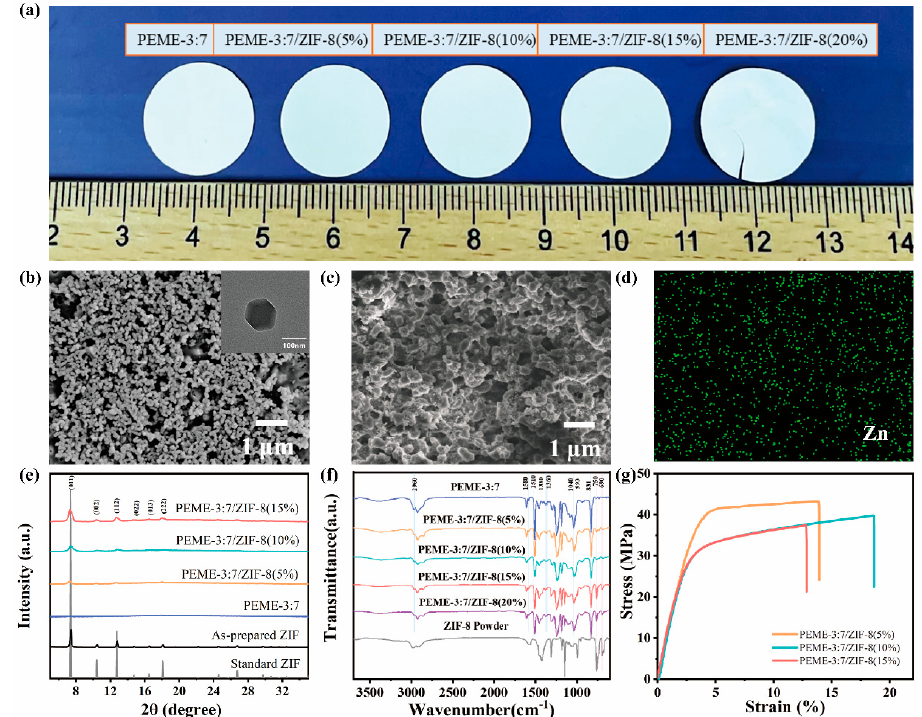
Figure 3. ( a ) Photographs of epoxy resin membranes with different ZIF-8 contents. The SEM images of PEME-3:7/ZIF-8(15%); ( b ) surface (inset: the corresponding TEM image of ZIF-8), and ( c ) cross- section; ( d ) Zn EDS mapping of PEME-3:7/ZIF-8(15%) membrane; ( e ) XRD patterns; ( f ) FTIR spectra, and ( g ) tensile stress–strain curves of different components.